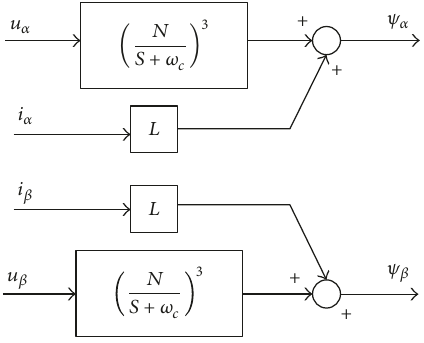
Figure 3: New virtual flux-linkage